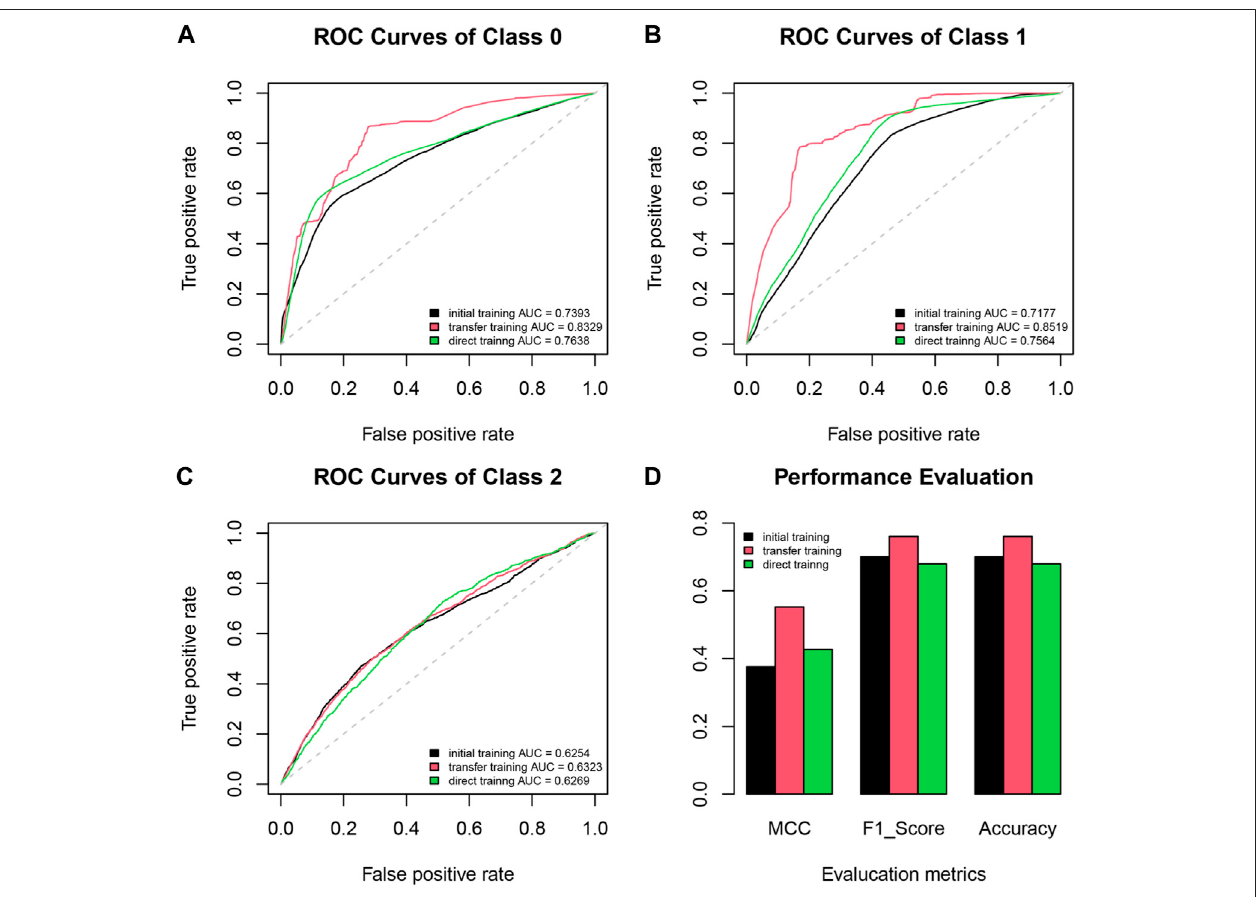
FIGURE 6 | Receiver operating characteristic (ROC) curves comparing the performance of initial training, transfer training, and direct training for (A) class 0, (B) class 1 and (C) class 2. (D) Bar plot curves of Matthews correlation coef fi cient (MCC), F1 score, and accuracy.